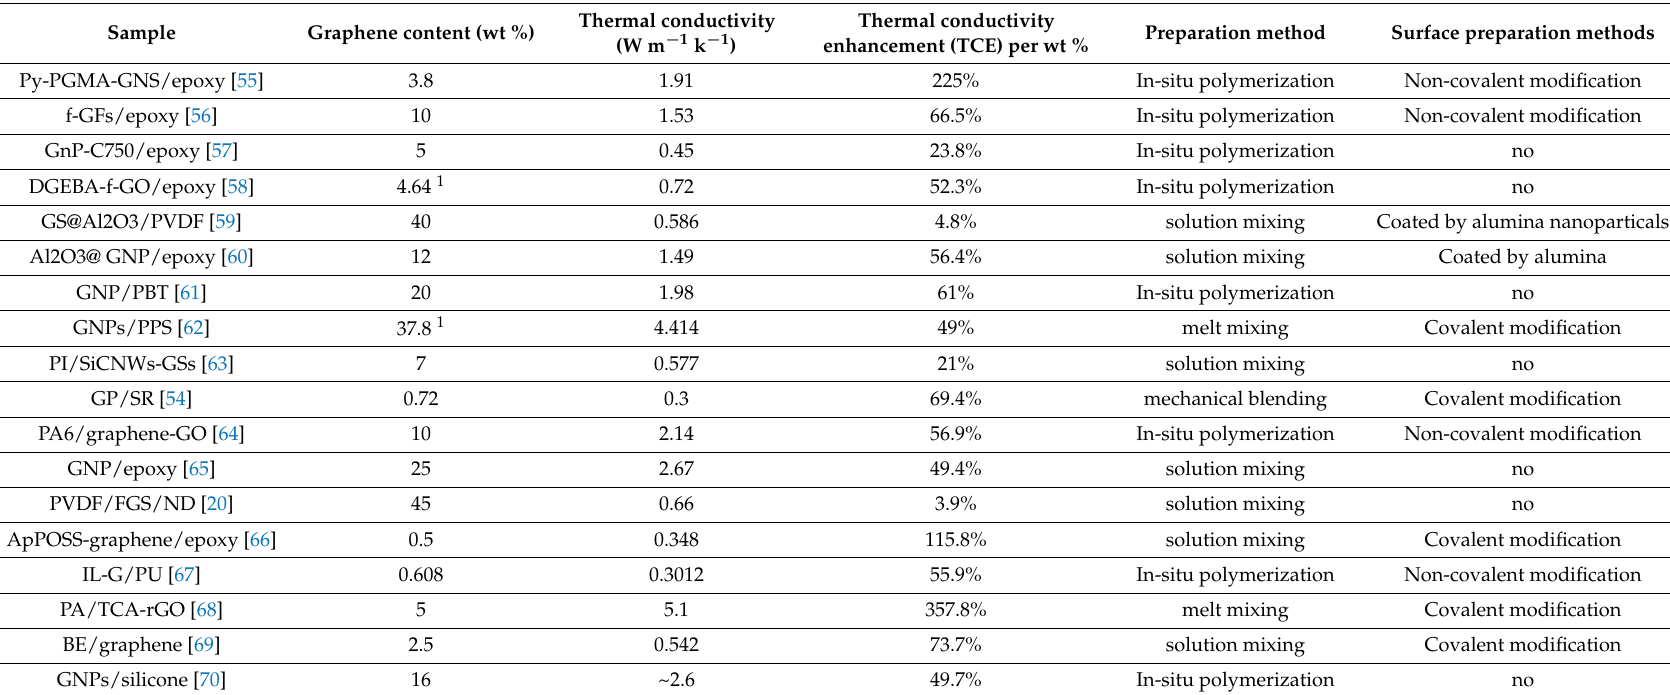
Table 1. Thermal conductivity of polymer composites filled with graphene and graphene-related materials with a random